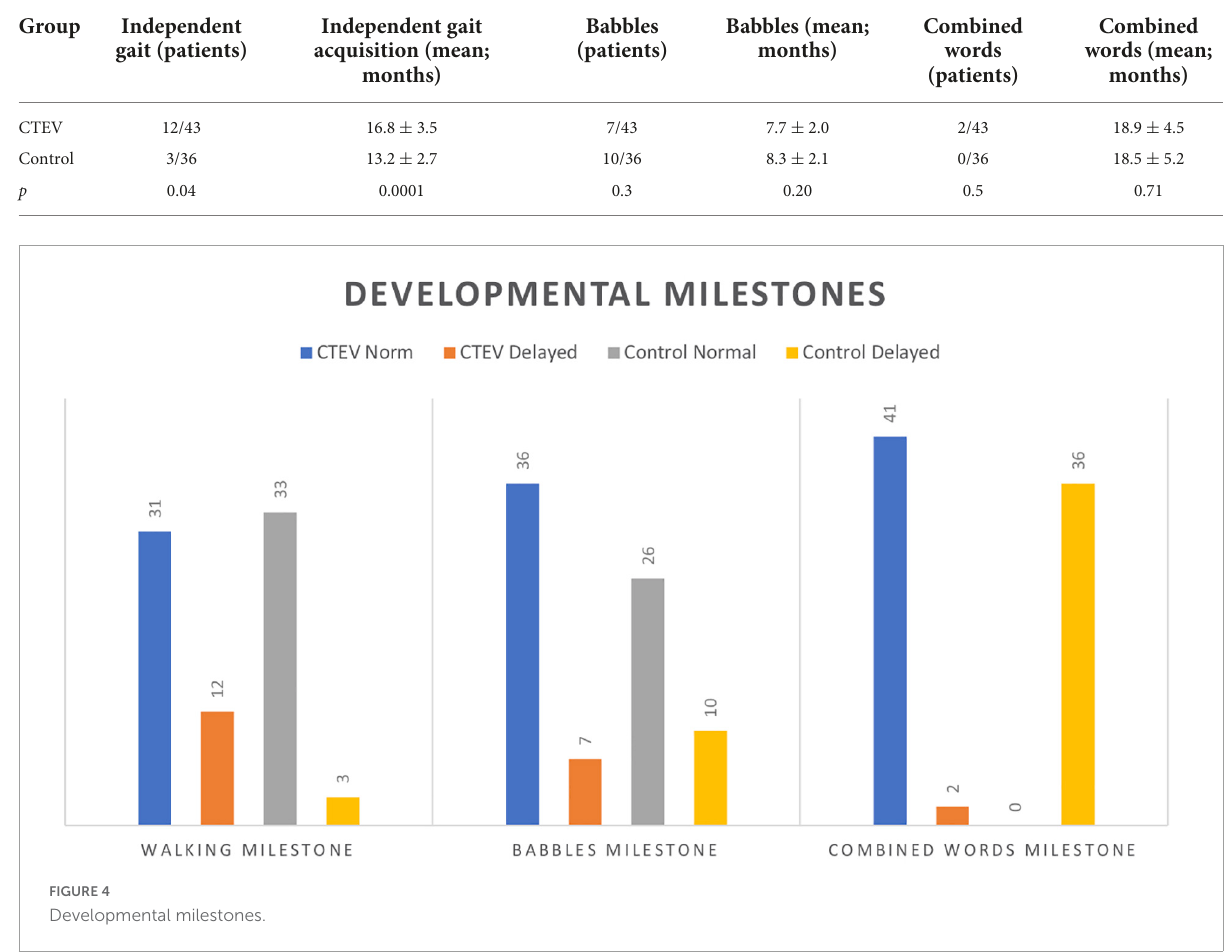
FIGURE4 Developmental milestones.